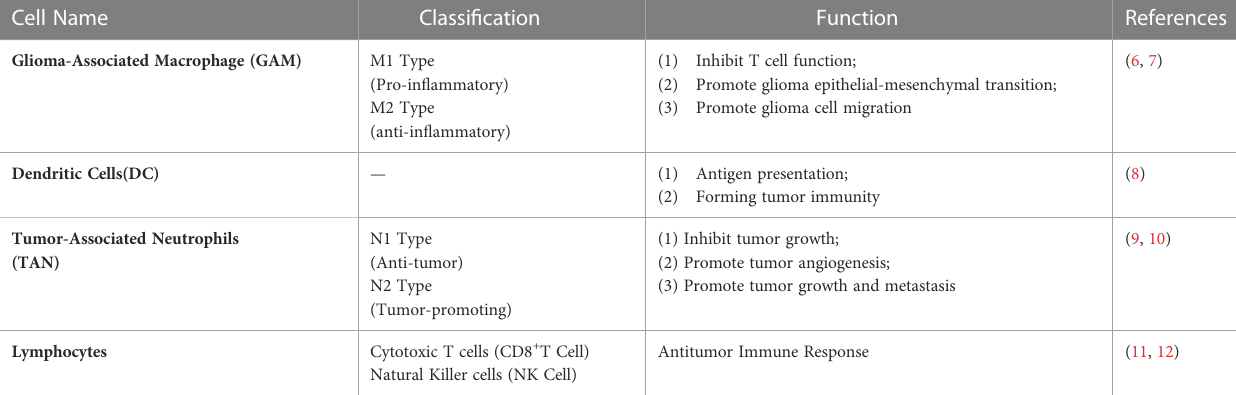
TABLE 1 Classi fi cation and function of immune cells in the immune microenvironment of brain